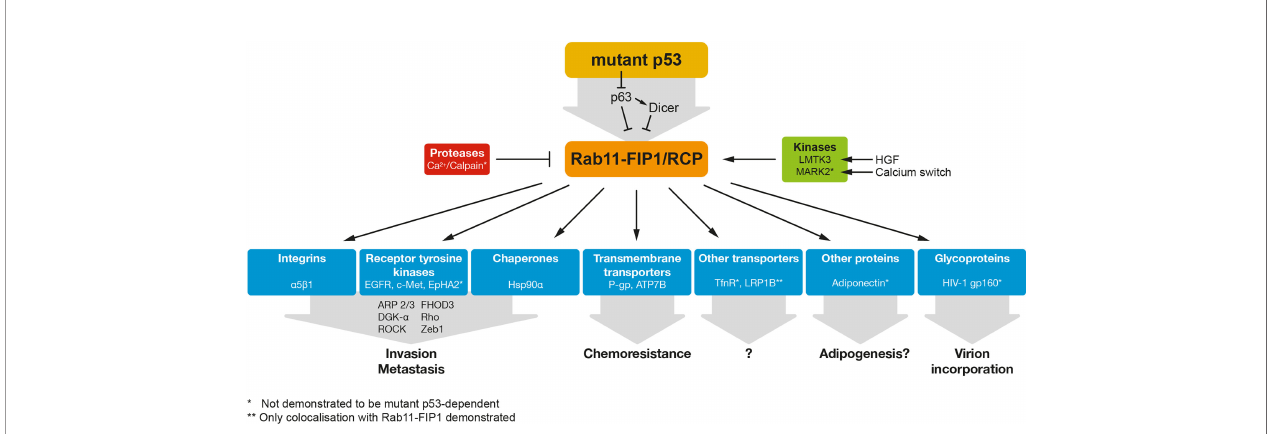
FIGURE 1 | Mutant p53 regulates RAB11-FIP1-dependent re-localisation of a variety of proteins. Mutant p53 can regulate RAB11-FIP1 by inhibiting the p53 family member p63 and/or the downstream target Dicer. Rab11-FIP1 enhances the re-localisation of a variety of proteins indicated in this fi gure. * indicates mutant p53 dependency. ** indicates only co-localisation demonstrated with